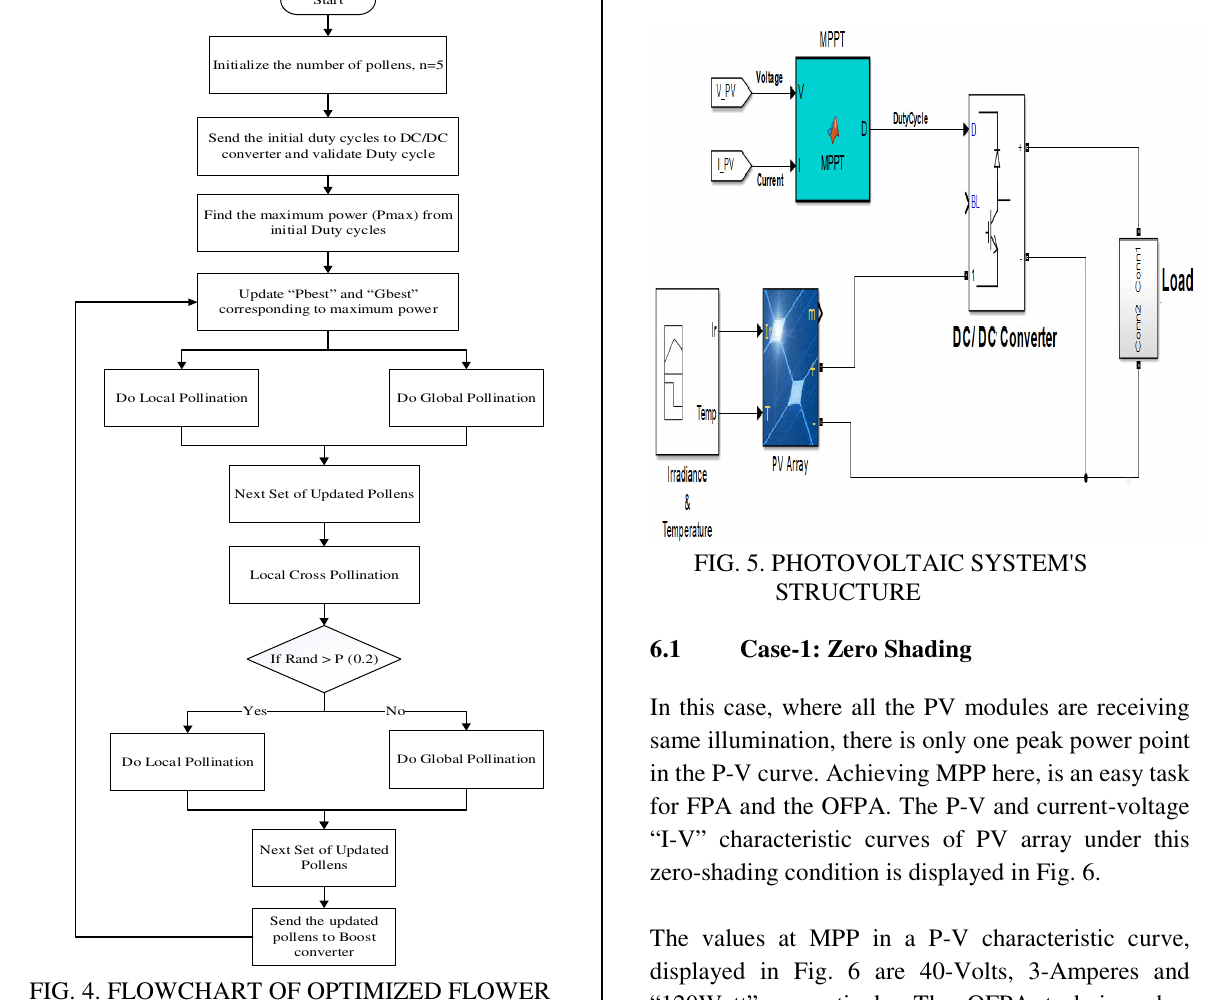
FIG. 4. FLOWCHART OF OPTIMIZED FLOWER POLLINATION ALGORITHM